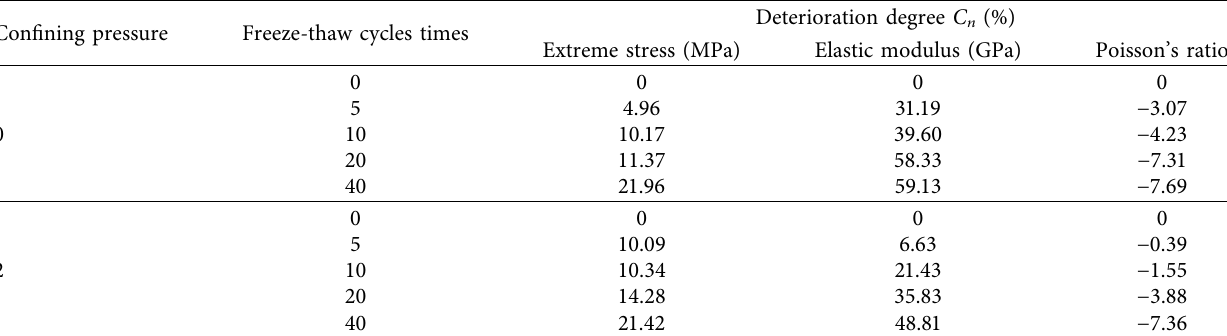
� 0MPa. 3 Deterioration degree C n